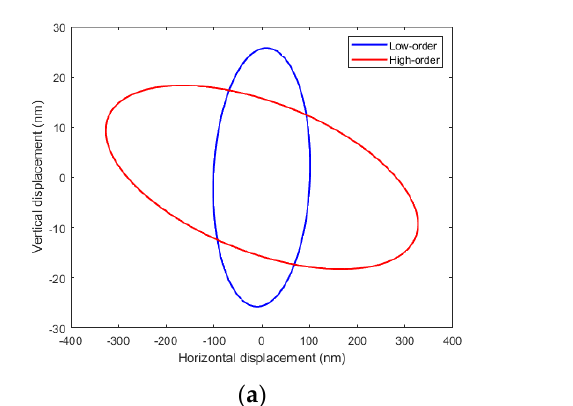
( b ) Figure 8. Speed of the TW robot with the low-order combination with 0.8 and 1.2 mm long legs for ( a ) leftward movement, and ( b ) rightward movement.